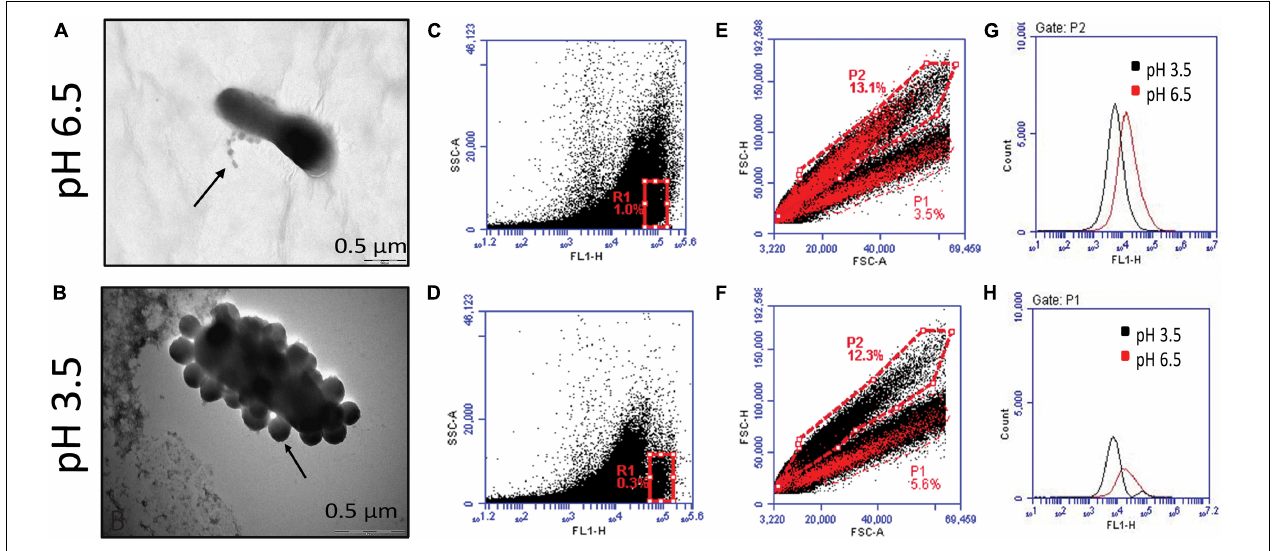
FIGURE 3 | Characterization of G. vaginalis ATCC 14019 MVs obtained at pH 6.5 and 3.5 by flow cytometry. Enlarged images of negatively stained bacteria depicting release of MVs at pH 6.5 (A) and pH 3.5 (B) . Fluorescence based side scatter profile of MVs at pH 6.5 (C) and pH 3.5 (D) indicating the presence of a distinct subset at pH 3.5 gated as R1. Forward scatter plot of area vs height for total population of MVs at pH 6.5 (E) and pH 3.5 (F) , superimposed with R1 gated population. Fluorescence profiles of the P2 (G) and P1 subsets (H) of the total population (E,F) at pH 6.5 and pH